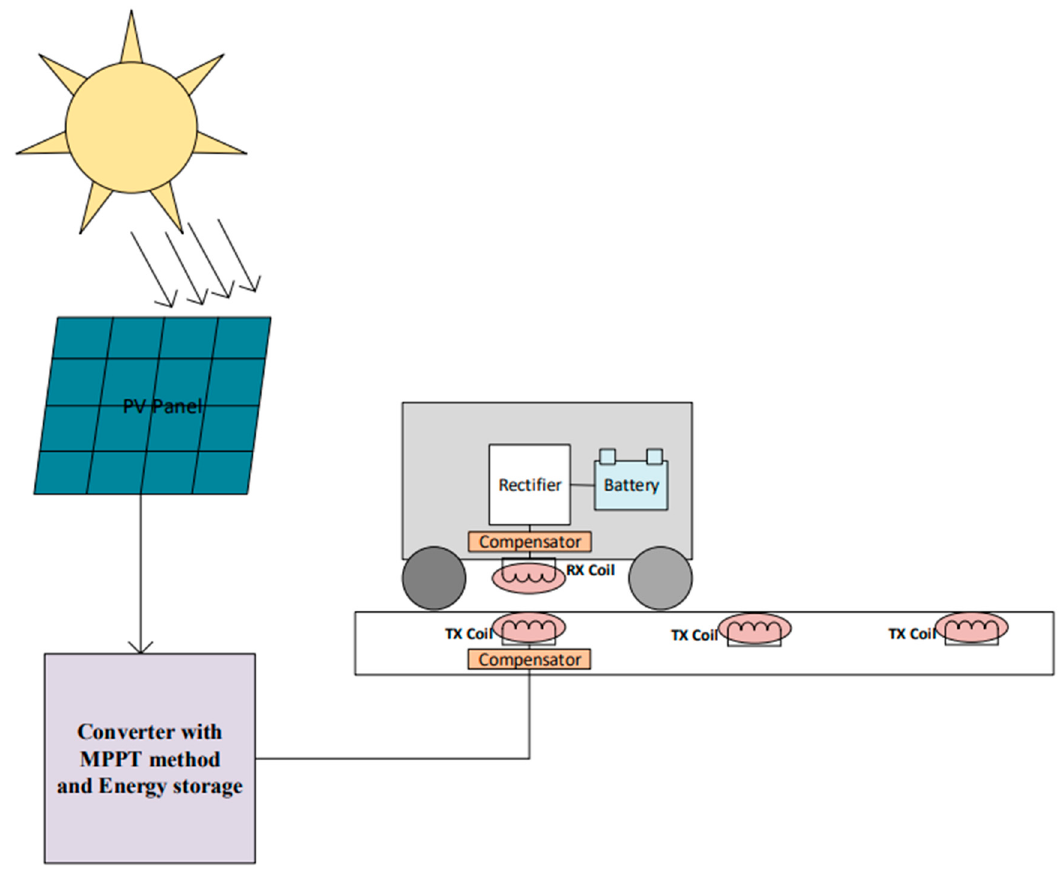
Figure 9. Basic diagram of dynamic wireless electric vehicle charging system.